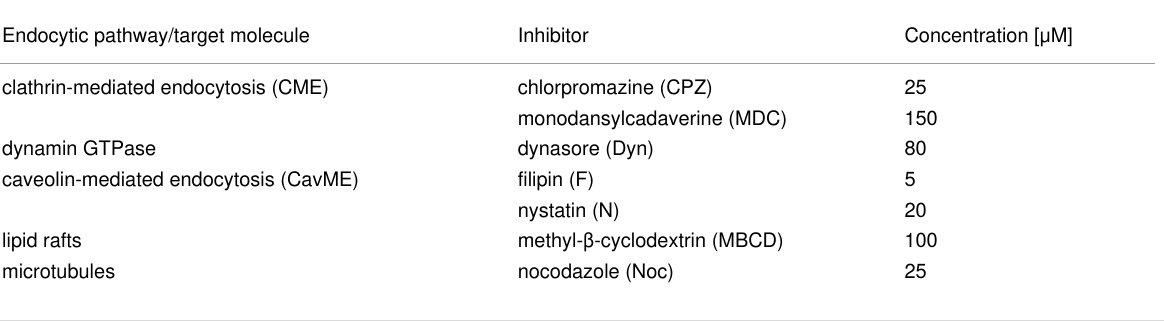
Table 2: Inhibitors of endocytosis and cytoskeleton